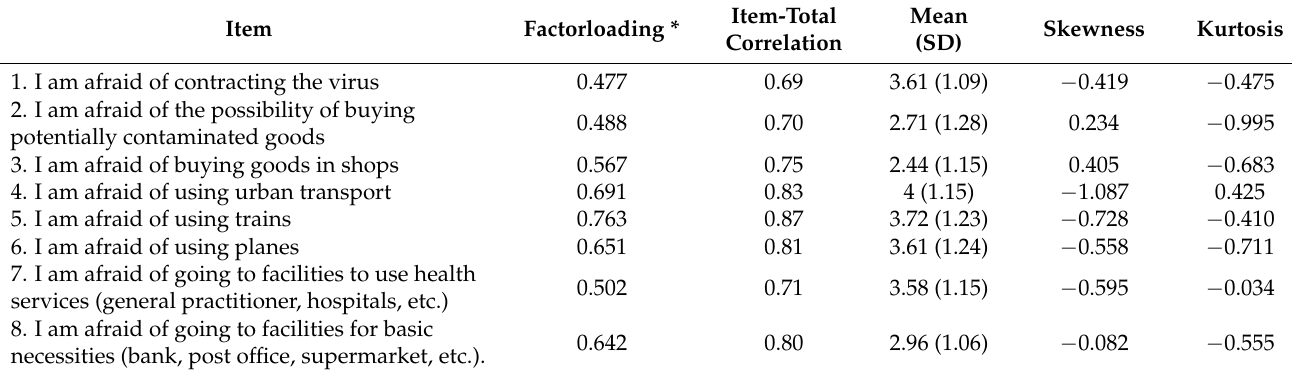
Table 3. Items and psychometric properties of the fear of COVID-19